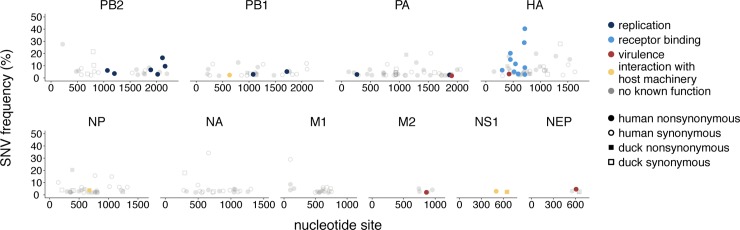
Mutations are present at functionally relevant sites.We queried each amino acid changing mutation identified in our dataset against all known annotations present in the Influenza Research Database Sequence Feature Variant Types tool. Each mutation is colored according to its function. Shape represents whether the mutation was identified in a human (circle) or duck (square) sample. Mutations shown here were detected in at least 1 human or duck sample. Filled in shapes represent nonsynonymous changes and open shapes represent synonymous mutations. Grey, transparent dots represent mutations for which no host-related function was known. Each nonsynonymous colored mutation, its frequency, and its phenotypic effect is shown in Table 3, and a full list of all mutations and their annotations are available in S1 Table.